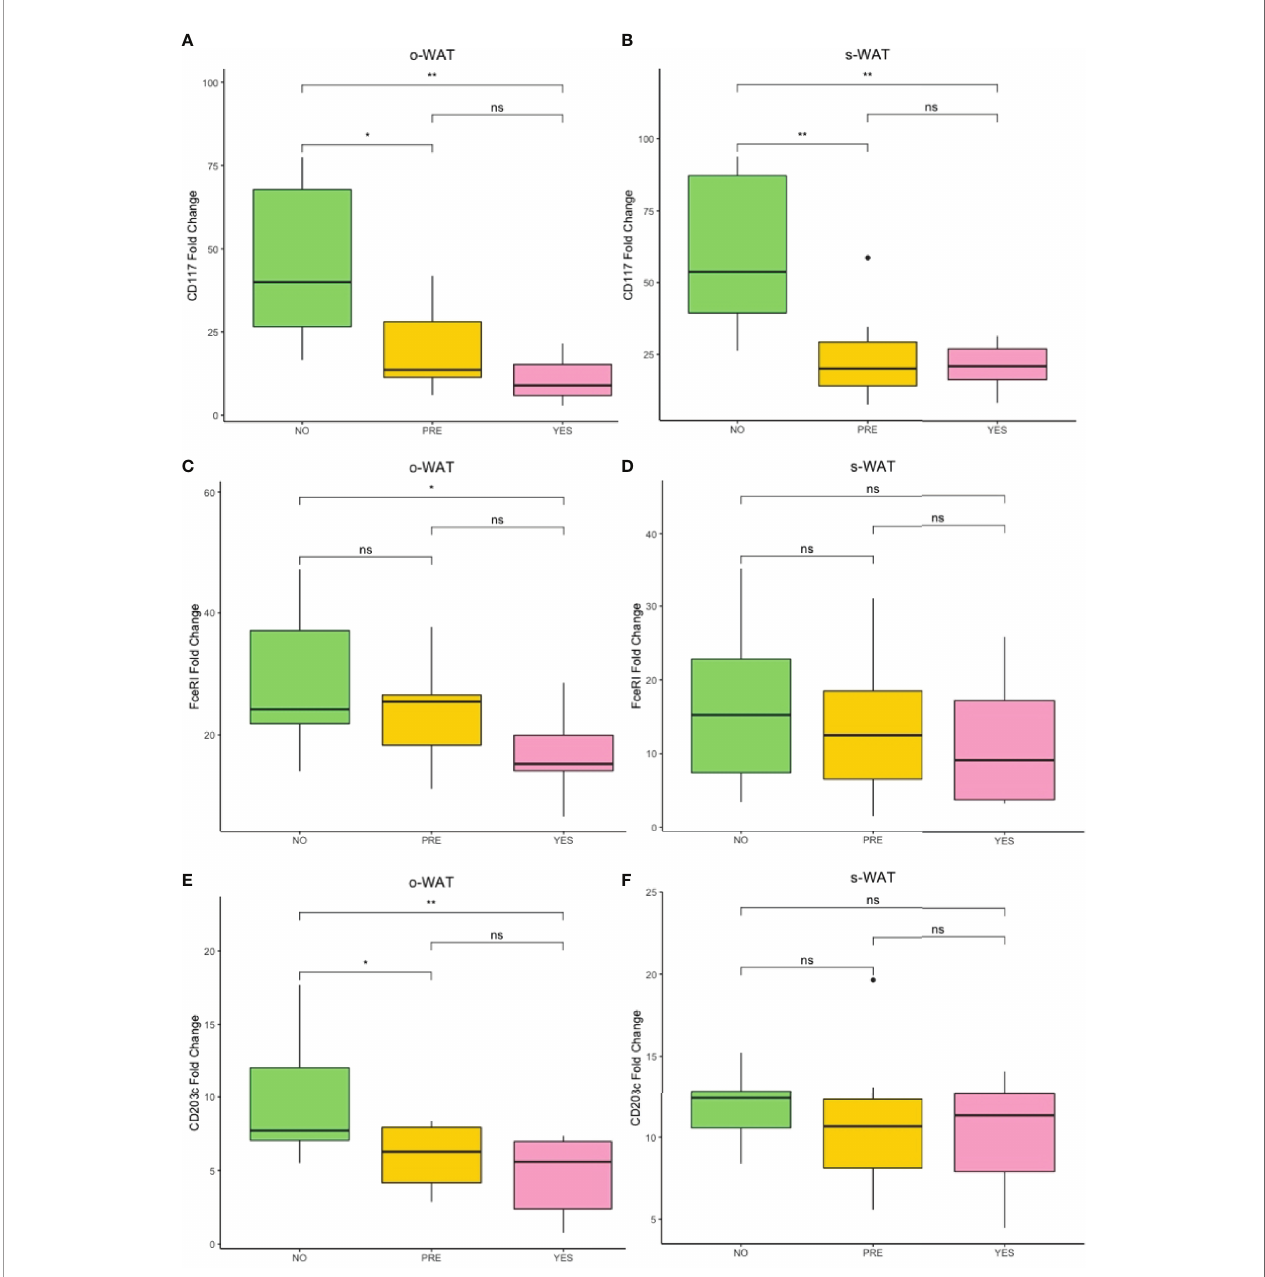
FIGURE 6 | Fold change variation of the expression of CD117, FceRI, and CD203c. (A) Comparison of the fold change variation of CD117 in o-WAT between the three groups. (B) Comparison of the fold change variation of CD117 in s-WAT between the three groups. (C) Comparison of the fold change variation of FceRI in o- WAT between the three groups. (D) Comparison of the fold change variation of FceRI in s-WAT between the three groups. (E) Comparison of the fold change variation of CD203c in o-WAT between the three groups. (F) Comparison of the fold change variation of CD203c in s-WAT between the three groups. NO (non-type 2 diabetes group), PRE (pre type 2 diabetes group), YES (type 2 diabetes group), T2D (type 2 diabetes), s-WAT (subcutaneous white adipose tissue), o-WAT (omental white adipose tissue), n=60. “ ns ” means not signi fi cant, * (0.05 > p value > 0.01), ** (0.01 > p value >